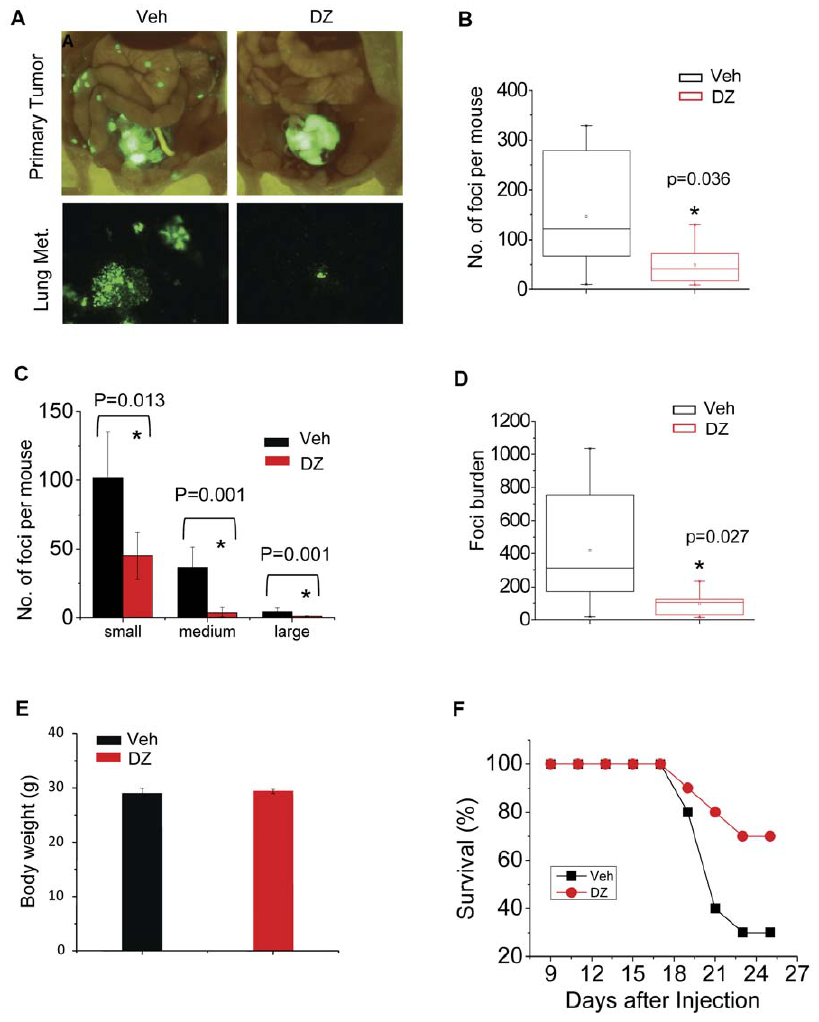
Figure 7. Doxazosin inhibits distal metastasis of human prostate cancer cells from orthotopic xenograft and prolongs survival. (A) Fluorescent images of prostate tumors and lung metastases resulting from GFP-tagged PC3-DAB2IP KD cells after 10 days of treatment with either vehicle, or 50 mg/kg doxazosin. Tumors in the prostate gland were imaged in a GFP light box, while lung metastatic foci were visualized under an inverted fluorescence microscope. (B) Graph comparing total number of metastatic lung foci in individual vehicle-treated (n=7) and doxazosin- treated (n=8) mice. (C) Quantitative analyses of total number of metastatic lung foci from different size categories. Categories were based on foci diameter measured in number of cells (small=1–3 cells, medium=4–6 cells, large=7–10 cells). (D) Comparison of total metastatic burden (number of foci 6 foci diameter) in mice treated with vehicle control vs. those treated with doxazosin. (E) Graph comparing bodyweights of vehicle- and doxazosin-treated mice. Bars represent mean bodyweights. Error bars represent the SEM. Experiment was repeated three times with similar results. (F) Kaplan-Meier Plot showing prolonged survival in mice treated with doxazosin (n=8) compared with those treated with vehicle control (n=9). Mice were injected with the PC3-DAB2IP KD cells and treated as in (A) and closely monitored for survival. Those that became moribund were sacrificed. Similar results were obtained from three independent experiments.